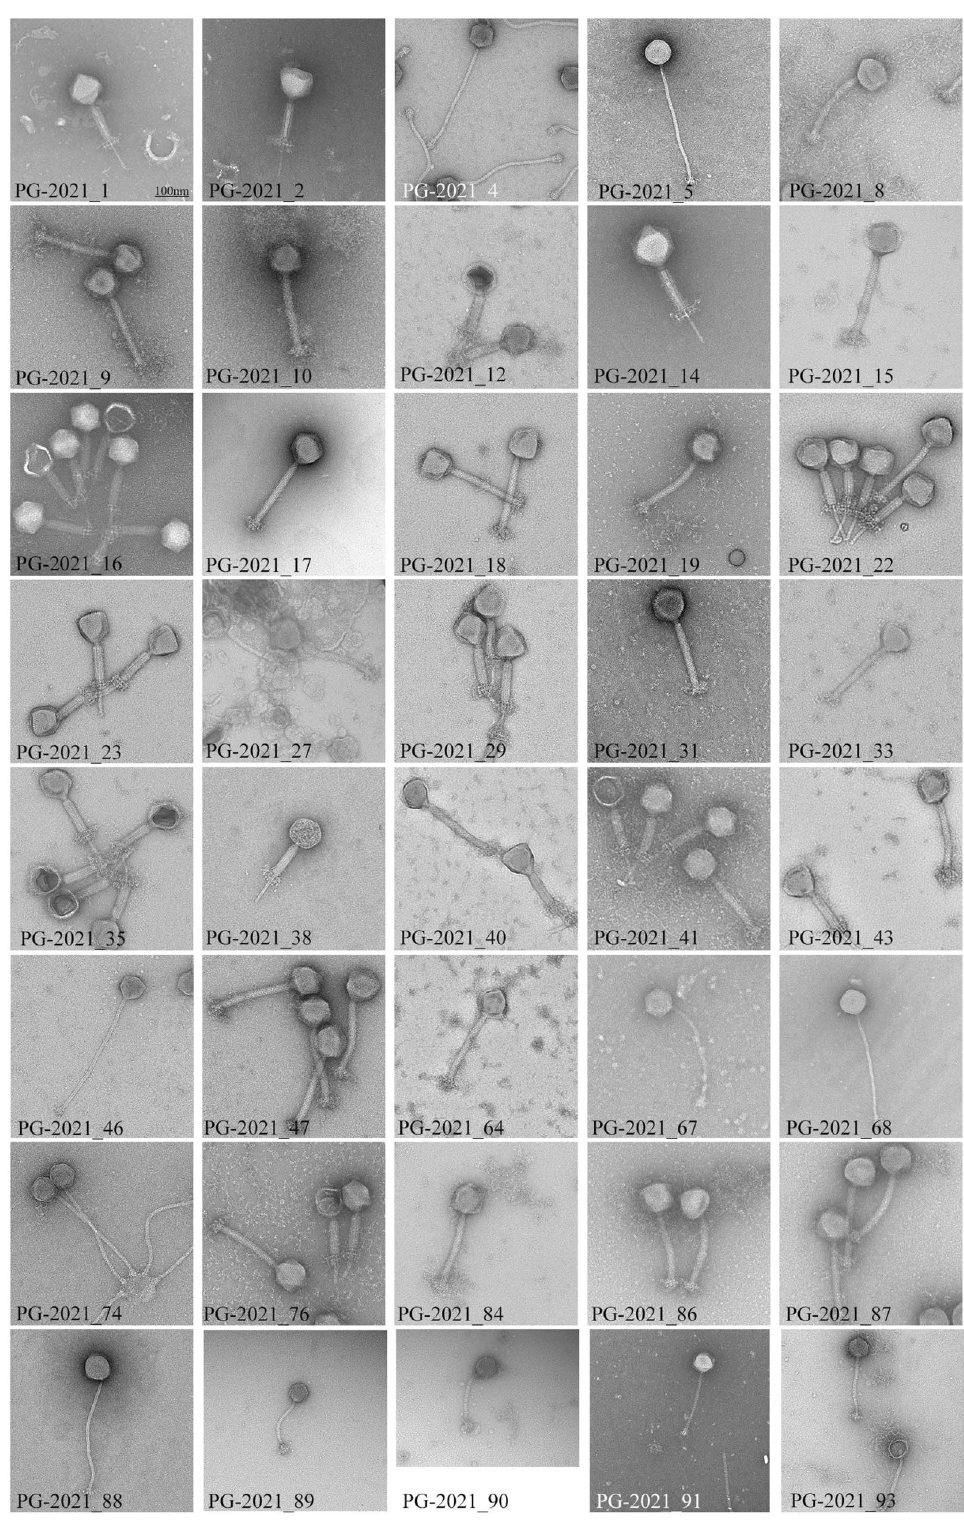
Fig. 5 Electron micrographs of the sequenced staphylococcal phages. Phages were isolated from the wastewater treatment plant inlet, outlet, or by induction of bacterial lysogens. For each phage, at least 10 representative pictures were taken. All pictures are adjusted according to the displayed scale- bar in the top-left